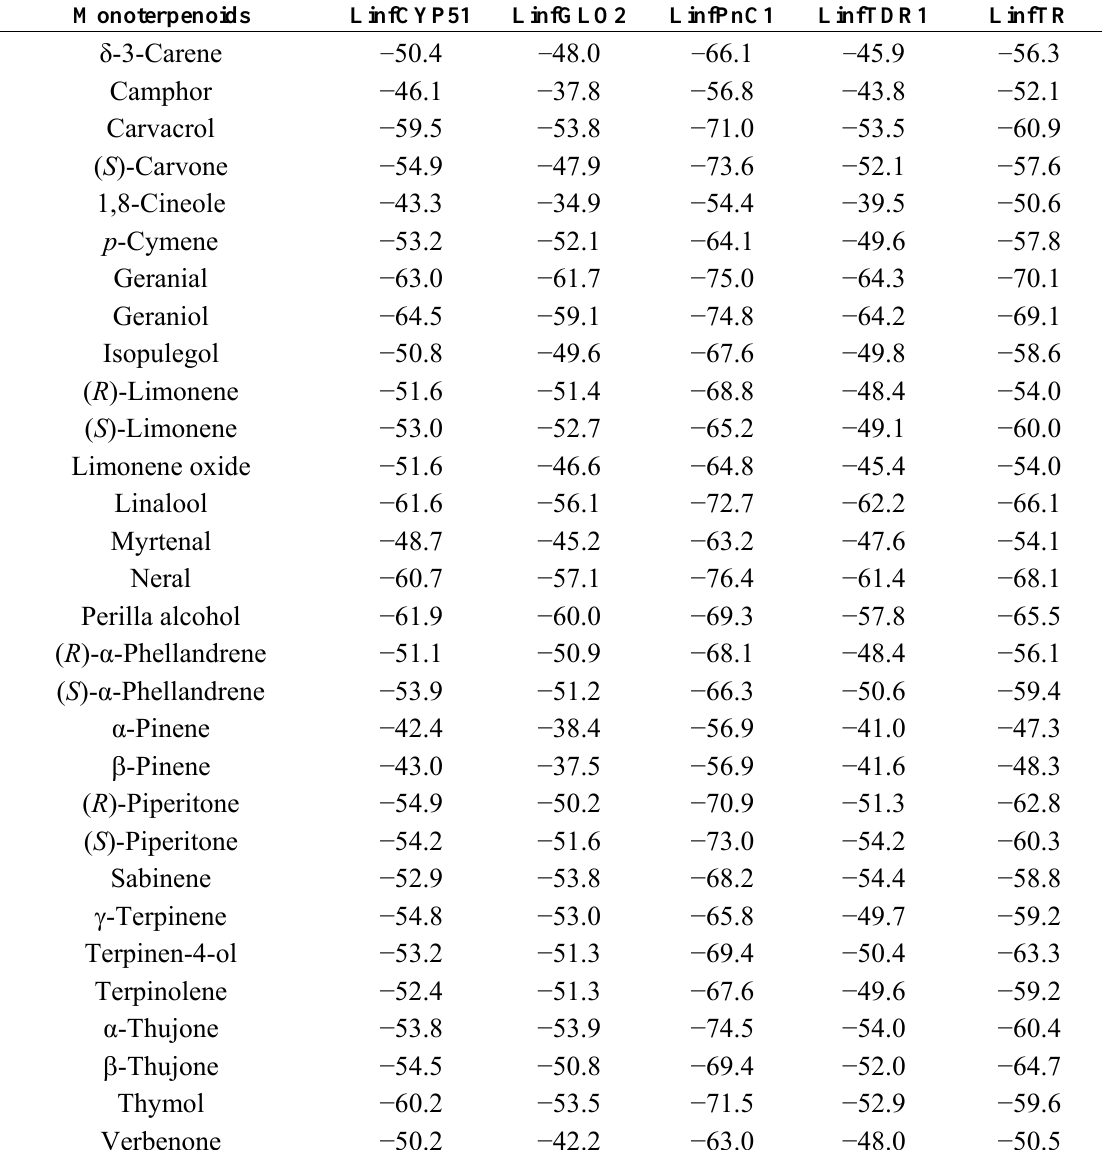
Table 3. MolDock docking energies (kJ/mol) of monoterpenoids with Leishmania infantum protein